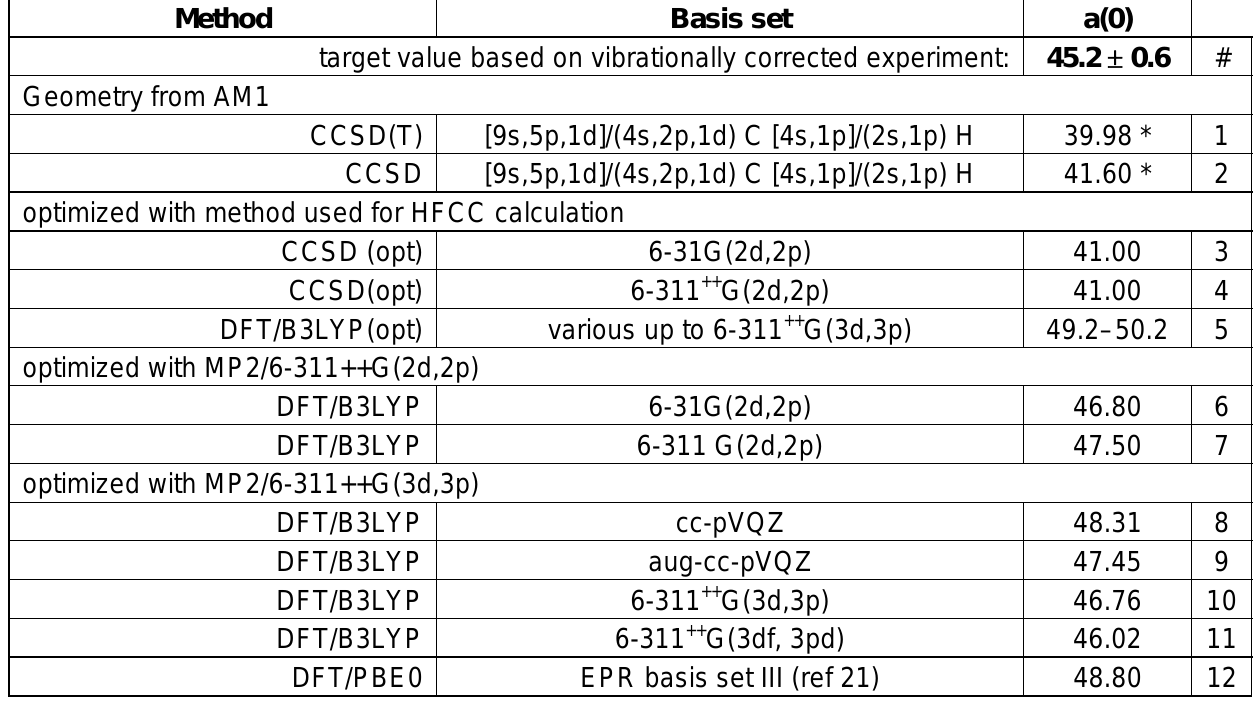
Table 2. Comparison of vibrationally corrected HFCC for H(1) with computed a(0)